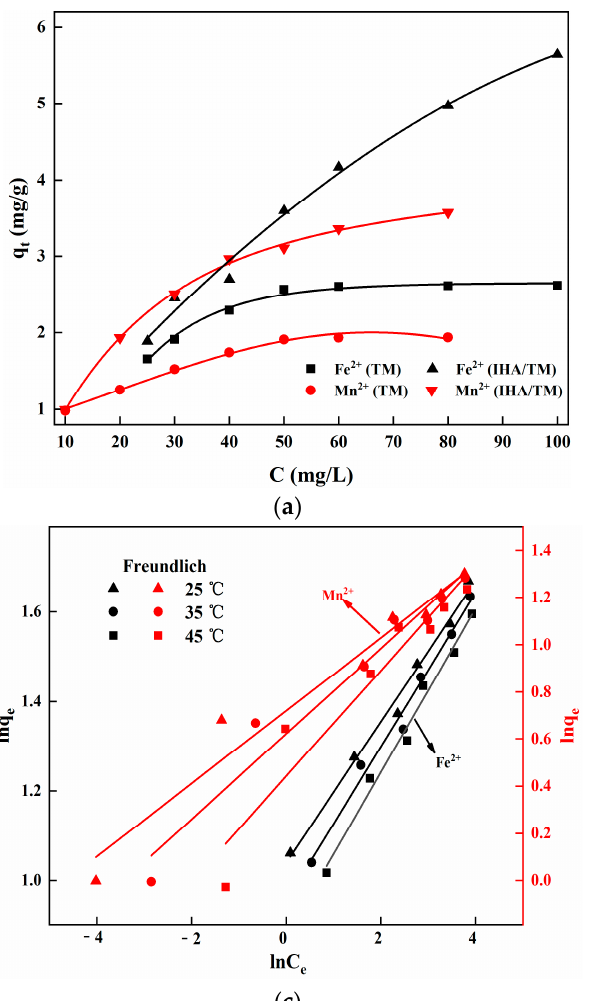
Figure 4. Isothermal adsorption of Fe 2+ and Mn 2+ onto TM and IHA/TM ( a ); equation fitting curve for the Langmuir model ( b ), Freundlich model ( c ) and Temkin model ( d ). To explore the adsorption behaviour of Fe 2+ and Mn 2+ on IHA/TM, the Langmuir, Freundlich and Temkin models were used to fit the isothermal adsorption data (Figure 4b–d).